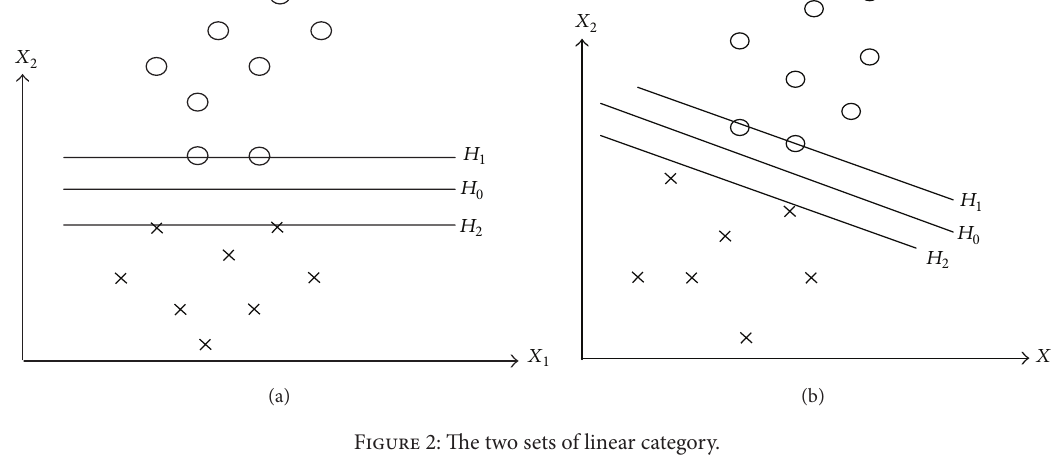
Figure 2: The two sets of linear category.